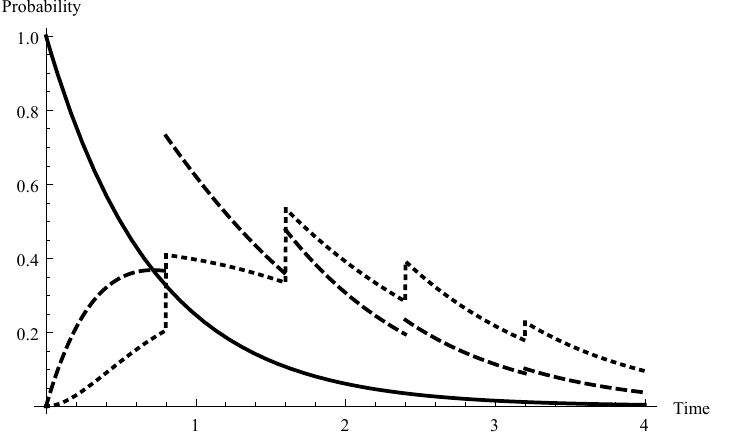
Figure 3. Transient probabilities P { X ( t ) = m , t ∈ I 1 } for λ = 1.4 and for m =